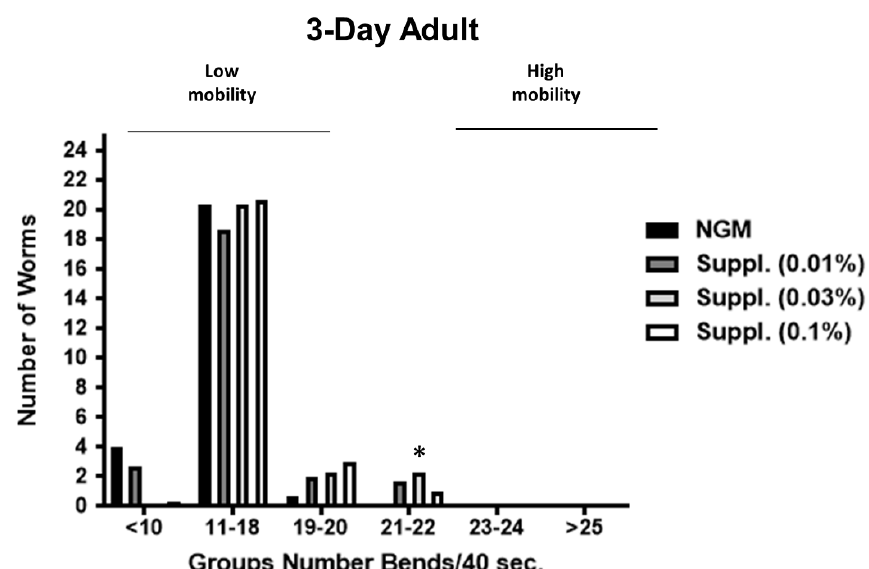
Figure 10. Distribution of mobility rate in 3-Day Adult worms used in the study. Different groups were established based on the speed (number of body bends/40 s) of worms). One-way ANOVA was used to compare conditions within each group for the number of body bends. * Significant p < 0.05 vs. NGM (within the group).